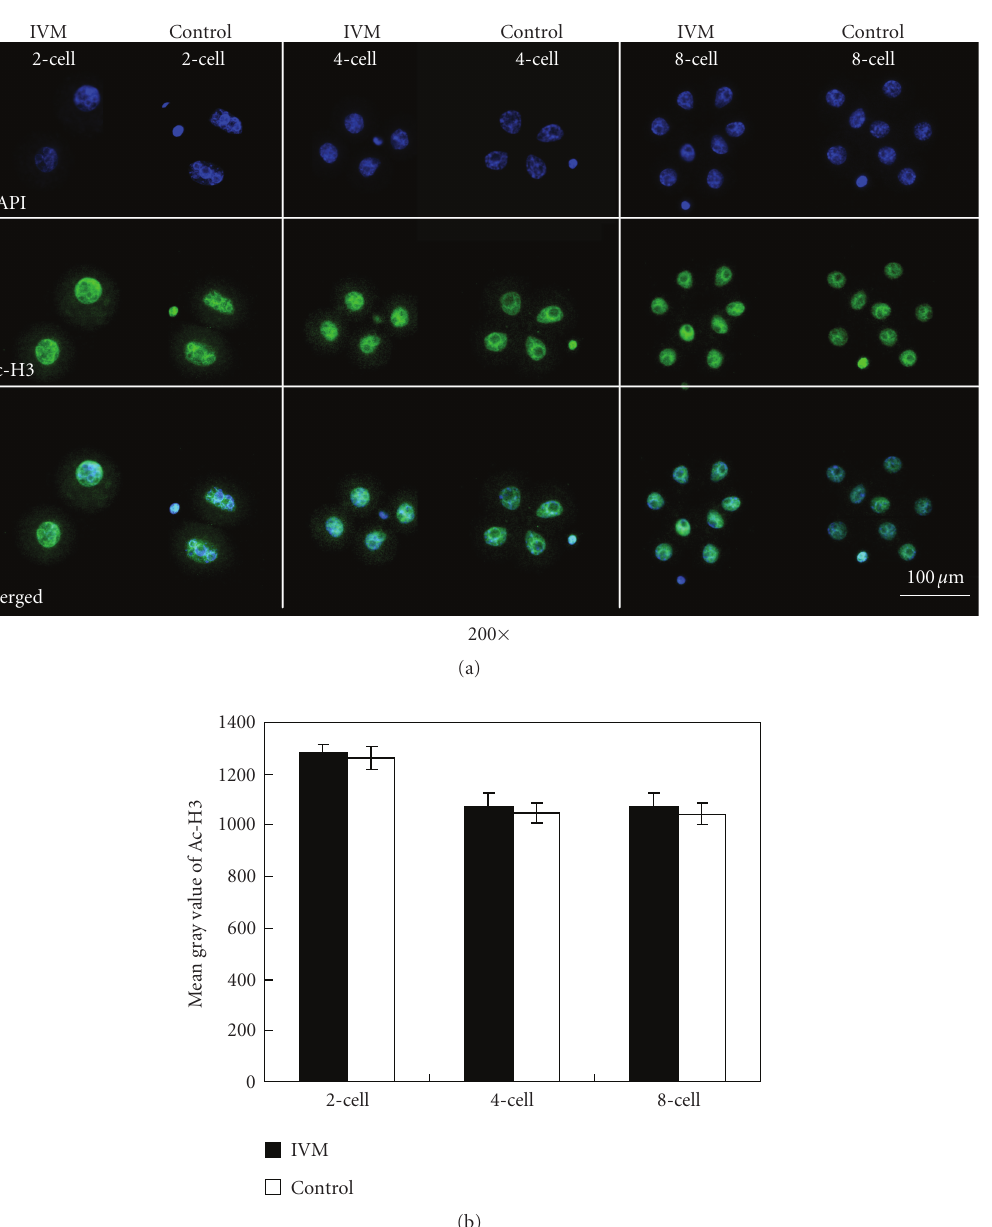
Figure 6: Fluorescence immunocytochemistry of Ac-H3 in oocytes and embryos. (a) Expression of Ac-H3 in 2-cell, 4-cell, and 8-cell embryos from IVM and control groups. Cells were immunostained with the Ac-H3 antibody. Each sample was counterstained with DAPI (blue) to visualize the DNA. Specific rabbit polyclonal Ac-H3 was detected by fluorescein-conjugated antirabbit secondary antibodies (green, FITC- labeled). Bar represents 100 μ m. (b) The gray value of GCN5 in oocytes and